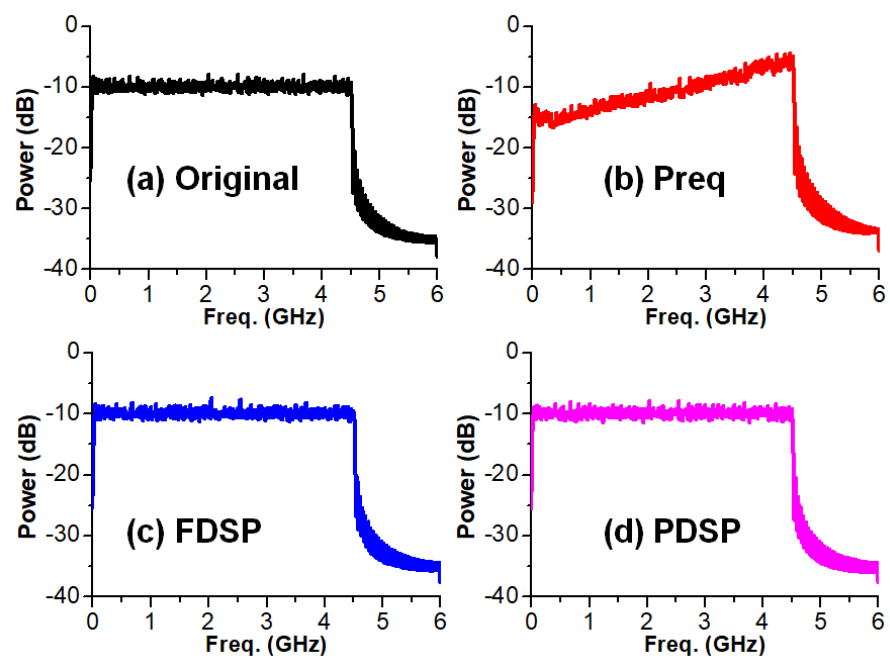
Figure 5. Spectral of the transmitted signals with ( a ) original scheme, ( b ) Preq scheme, ( c ) WHT-based FDSP scheme and ( d ) Fast WHT-based PDSP scheme.